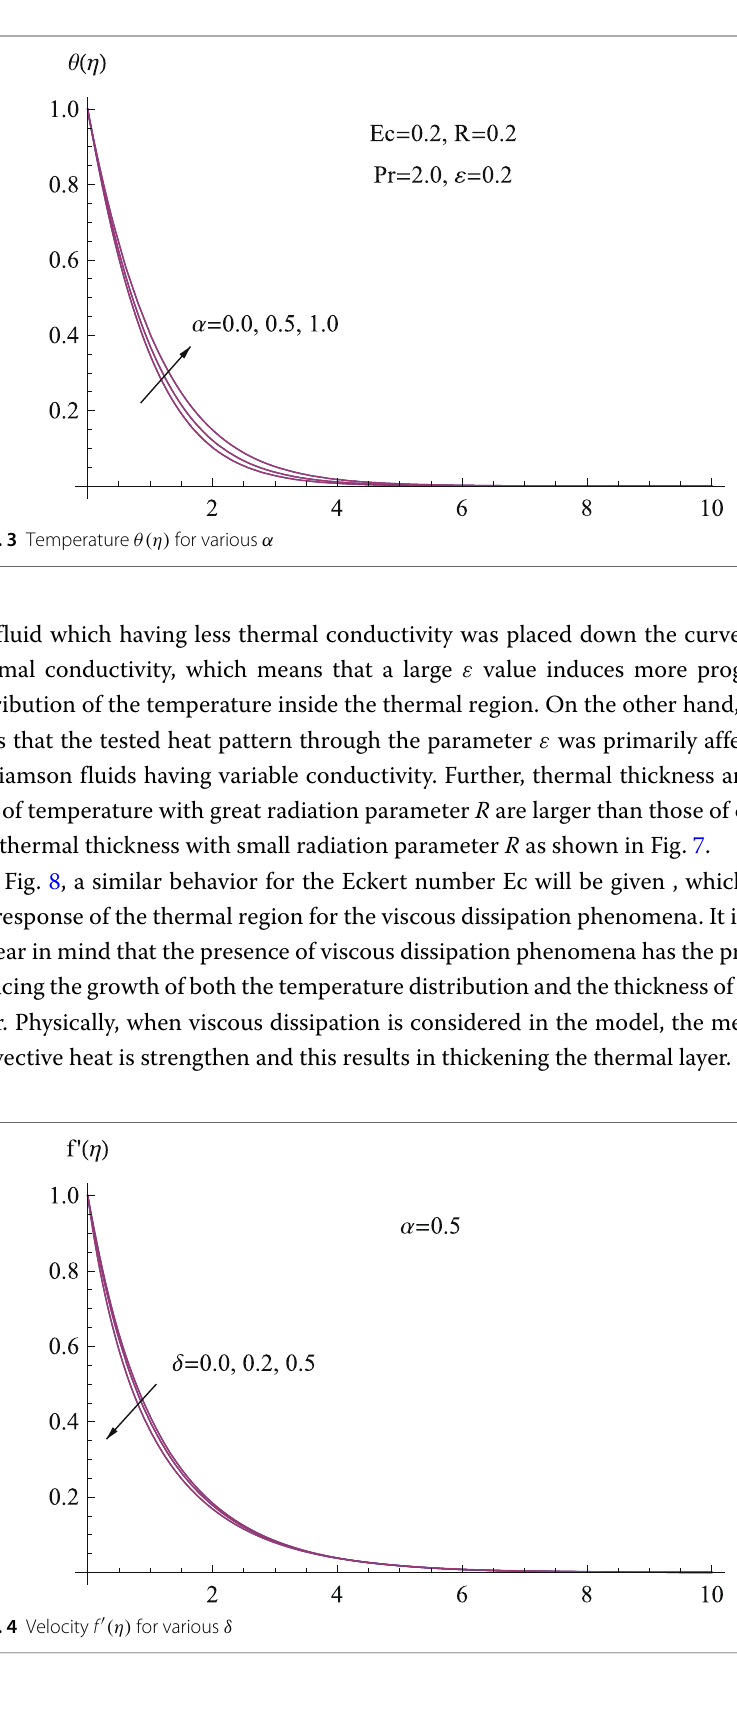
Fig. 4 Velocity f (cid:7) (η) for various